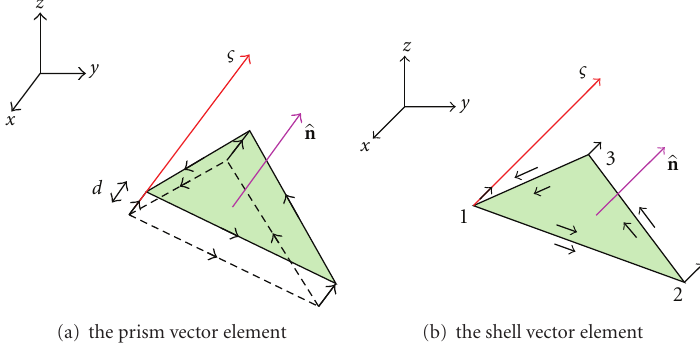
Figure 2: The structure of the prism vector element and the shell vector element.